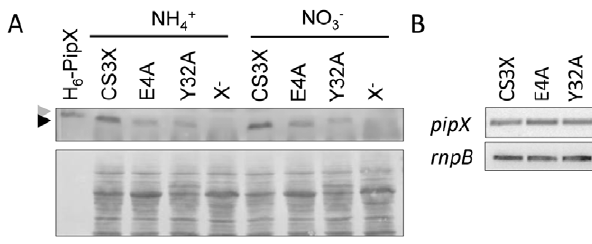
Figure 6. Effect of point mutations on PipX levels. (A) Immunodetection of PipX from strains expressing wild type PipX (CS3X) and the indicated PipX point mutation derivatives (Y32A, E4A) alongside a pipX null strain (X - ) using an Anti-PipX antibody. Detection of endogenous PipX and recombinant H 6 -PipX (10 ng loaded in a control lane) is indicated with black and grey arrowhead, respectively. 60 m g of protein extract were loaded per lane. A protein loading and transfer quality control is shown on the bottom panel. (B) Amplification of pipX and rnpB (used as a loading control) by RT-PCR in the CS3X and point mutant derivatives (E4A and Y32A) grown in the presence of nitrate. A representative experiment from two independent RNA extractions is shown.